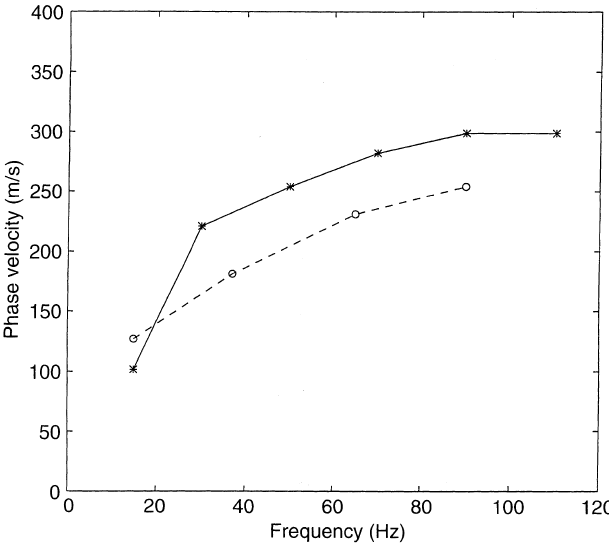
Fig. 9. Dispersion relation, i.e., phase velocity for various frequencies, obtained by band-pass filtering the data prior to the calculation of the cross-correlation. Solid line refers to upleg conditions, dashed line to downleg. The data are obtained for an altitude interval of approximately 2 km, centered around 102